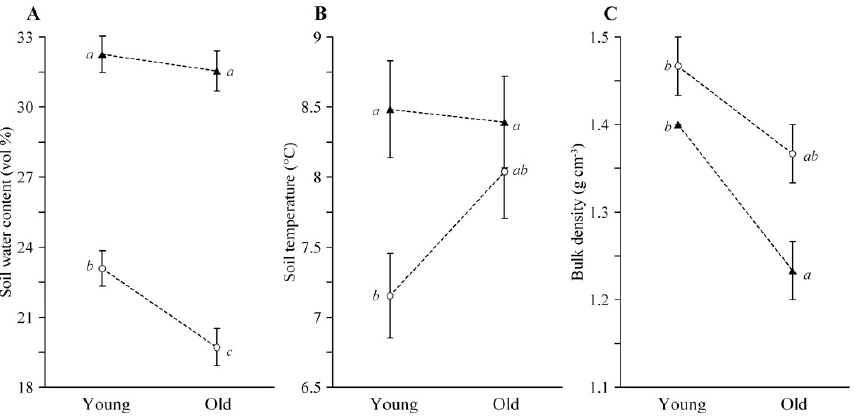
Fig. 3. Stand comparisons of average (A) N 2 O fluxes (µg N 2 O-N m − 2 h − 1 ) and (B) CH 4 fluxes (µg CH 4 -C m − 2 h − 1 ). Error bars ( ± std. error of the mean) represent the temporal variation. Different letters indicate significant difference ( p < 0 . 05). Oak ( N ) and Norway spruce ( ◦ ). Dashed lines are included for clarification and do not represent regression